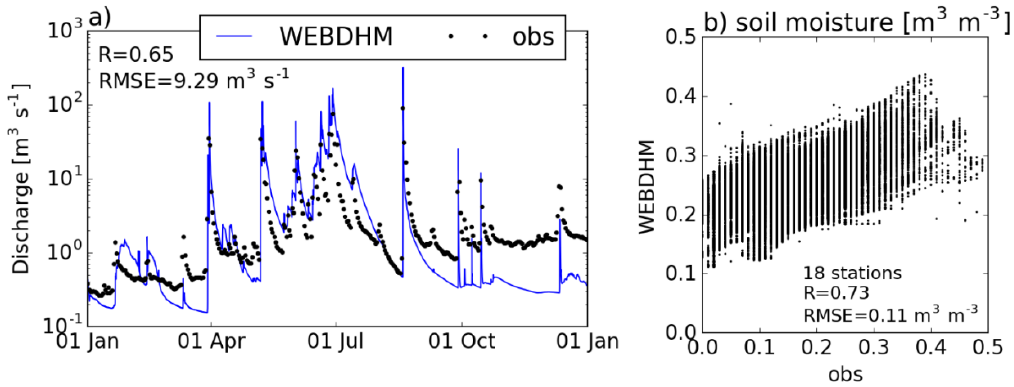
Figure A1. Validations of WEBDHM at the Little Washita basin: ( a ) Temporal variations of discharge by WEBDHM and an in-situ observation site; ( b ) scatter plots of surface soil moisture by WEBDHM and in-situ observation sites. The correlation coefficient (R) and root-mean-square error (RMSE) are indicated in each figure.